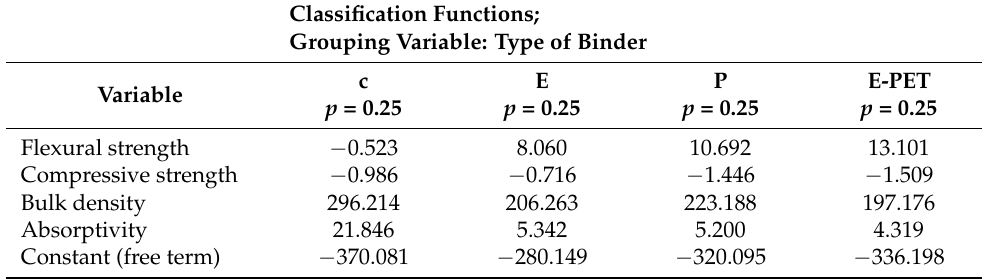
Table 8. Parameters of the classification